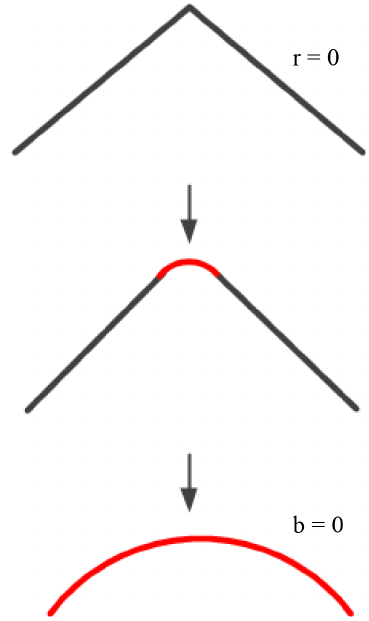
Figure 8. Schematic diagram of the transition from creased strip ( r = 0) to curved strip ( b =